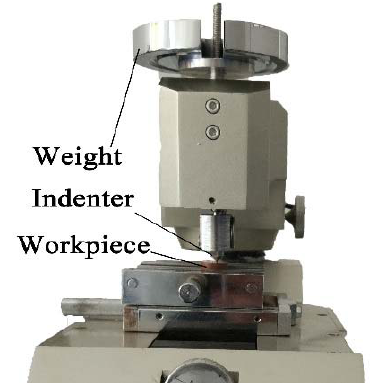
Figure 7. Experimental set ‐ up of the friction coefficient.